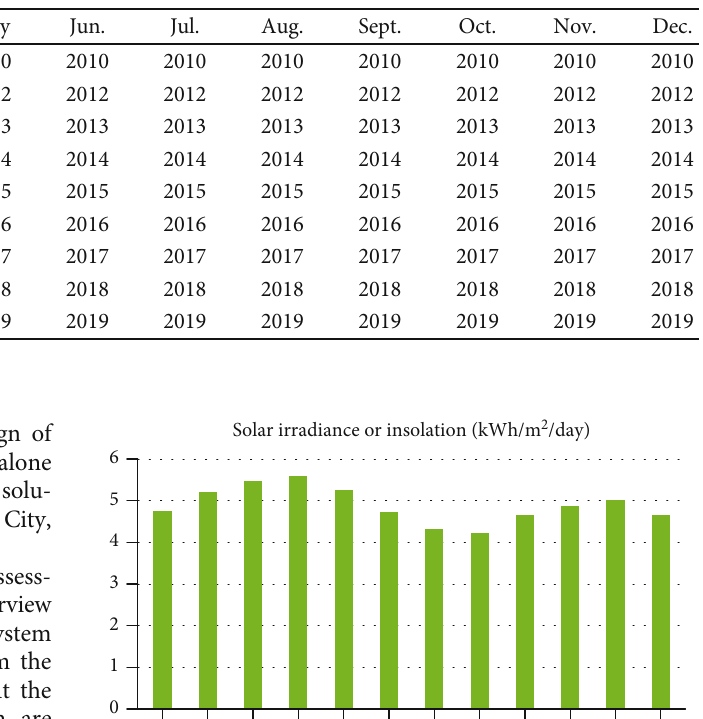
Table 1: Bahir Dar City monthly average sunshine hour data.